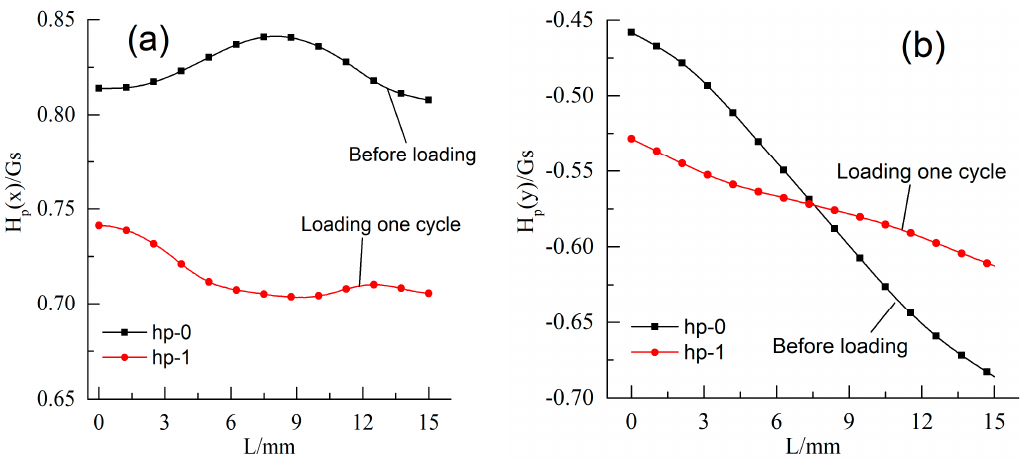
Figure 11. MMM signals of the specimen before and after load: ( a ) H p (x); and ( b ) H p (y).